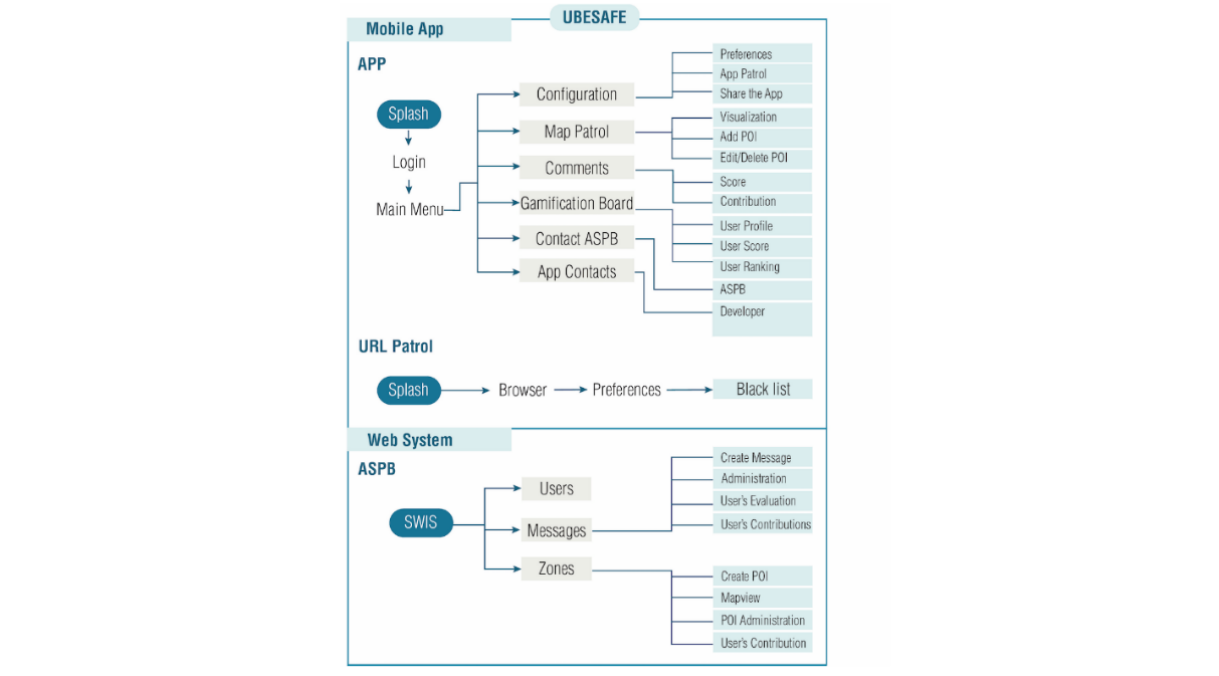
Figure 2. Flux of work of the app. ASPB: public health agency of Barcelona; SWIS: simple web interface system; POI: point of